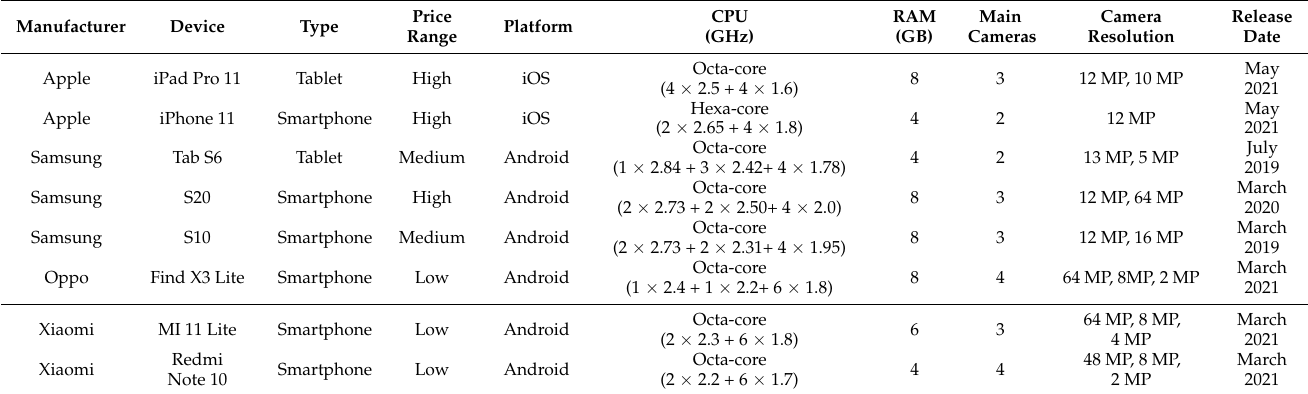
Table 1. Selected mobile devices and their main